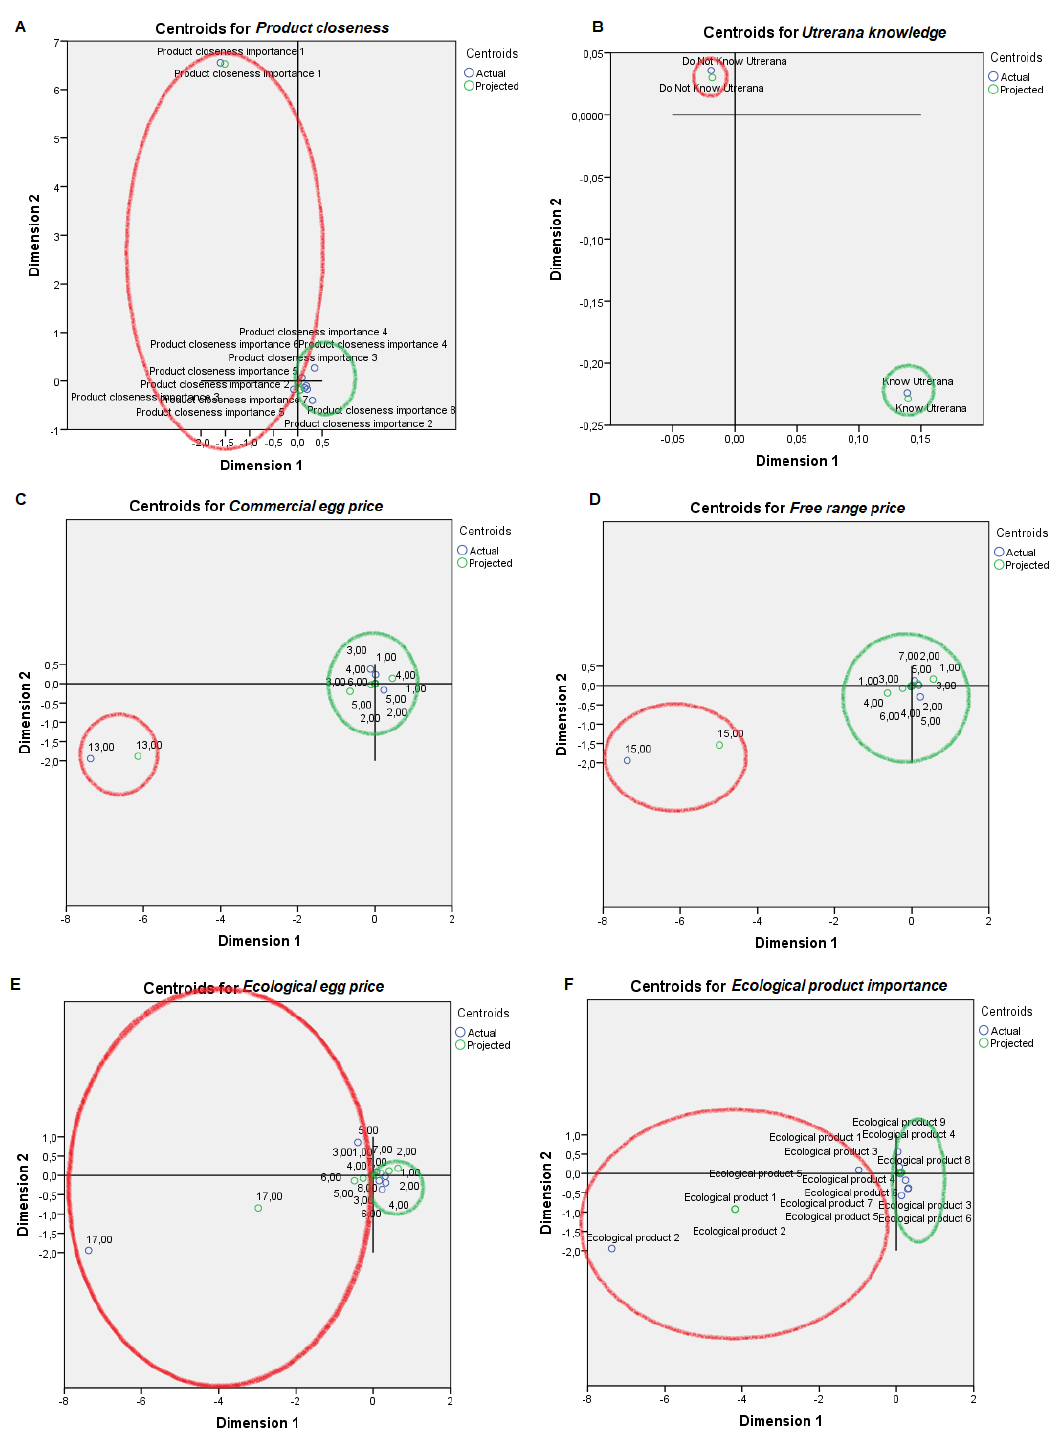
Figure 4. Figure 4. Cont .